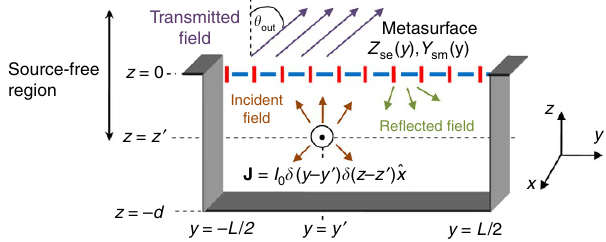
Figure 1 | Physical configuration of a cavity-excited Huygens’ metasurface antenna. An electric line source is positioned at (y 0 ,z 0 ), surrounded by three perfect-electric-conductor (PEC) walls at z ¼ (cid:3) d ; y ¼ (cid:4) L = 2, forming a lateral cavity. The cavity is covered by a Huygens’ metasurface of aperture length L situated at z ¼ 0, facilitating directive radiation towards y out